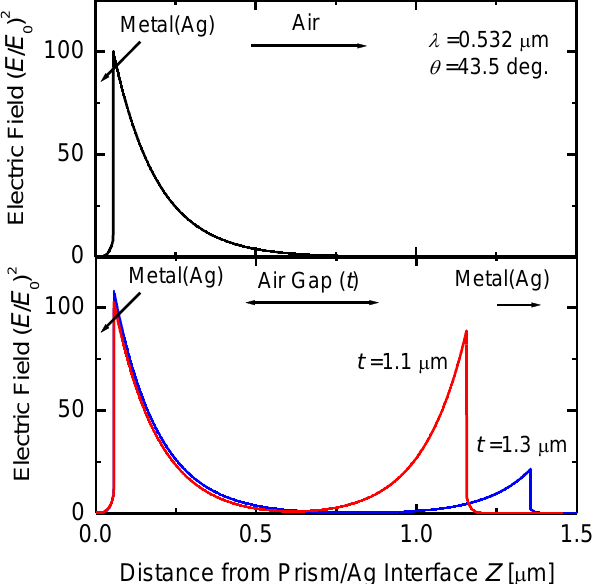
Figure 4. Calculated electric-field-intensity distributions in the thickness direction: the upper figure for the dielectric/metal thin film/air, the lower figure for the dielectric/metal thin film/air